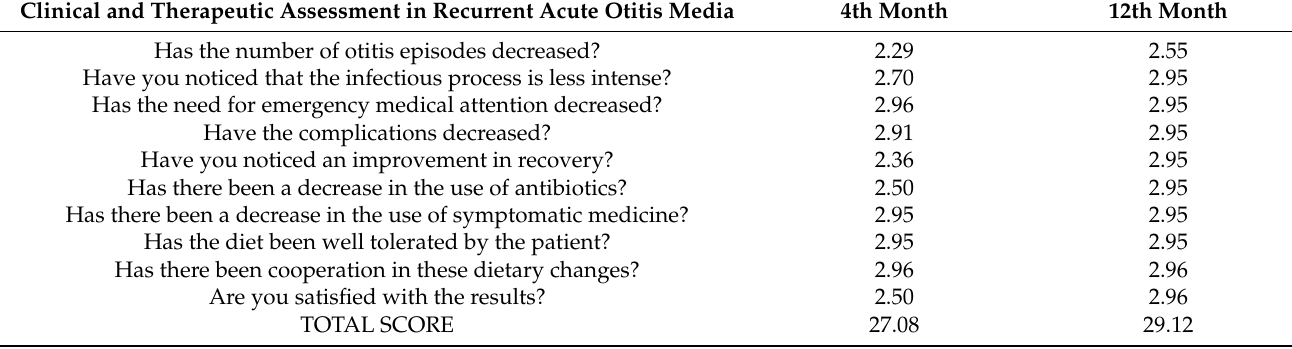
Table 1. Response of parents or guardians regarding the improvement observed in recurrent otitis.